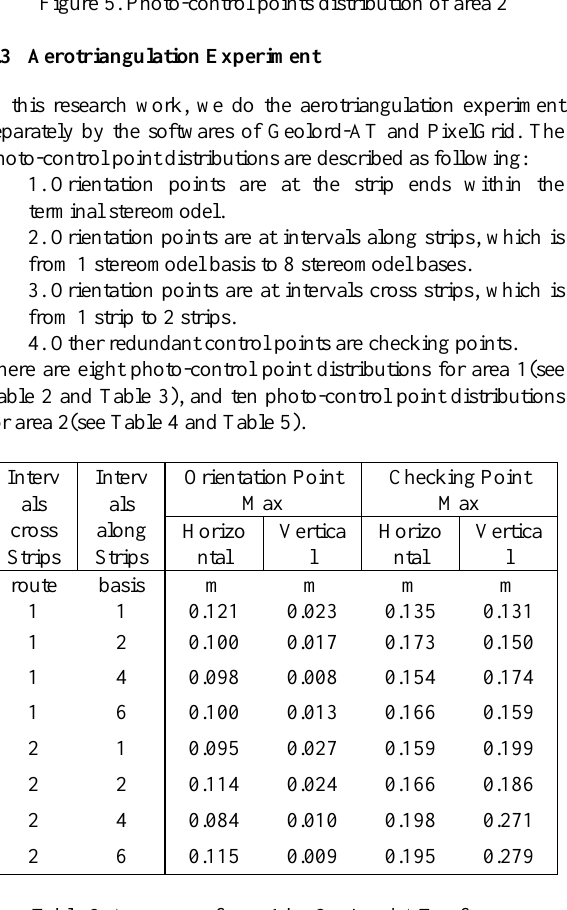
Table 2. Accuracy of area 1 by GeoLord-AT software